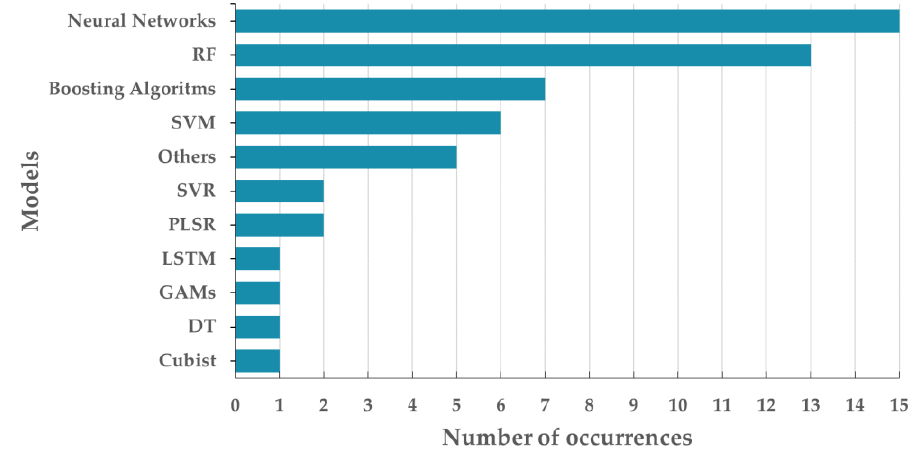
Figure 10. Overview of the modeling techniques adopted by the studies ( n = 28) in this review.